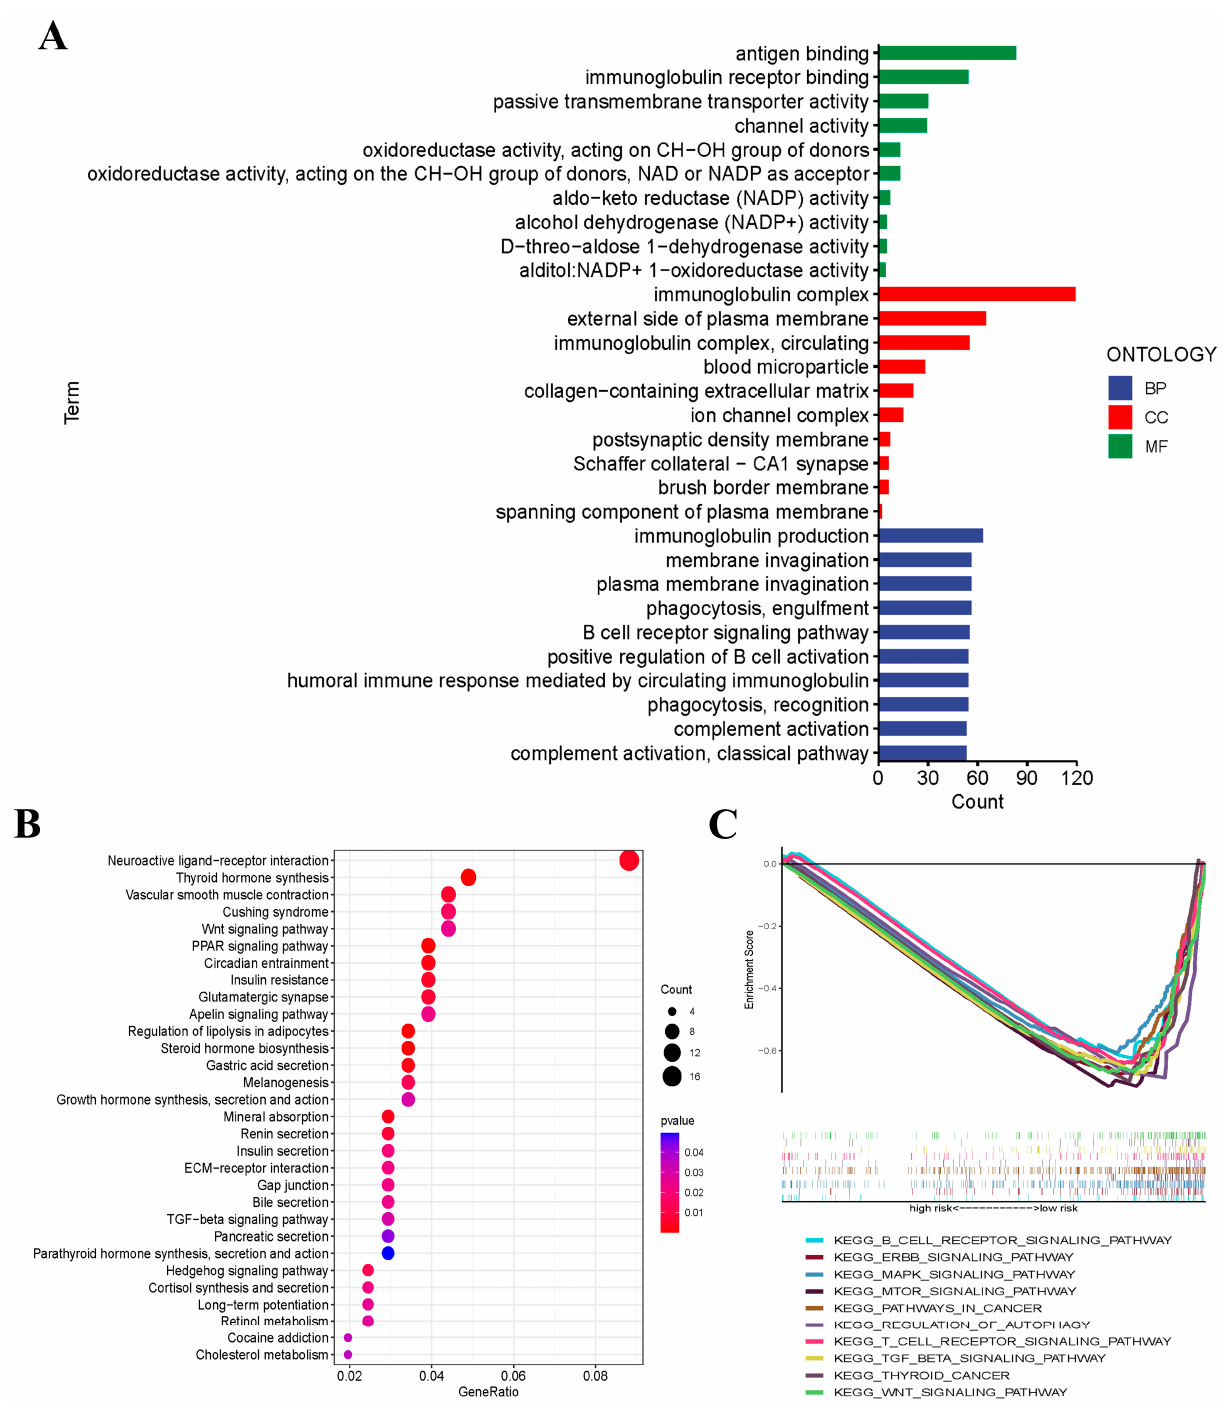
Figure 5. Functional enrichment analysis based on the DEGs. ( A ) Barplot graph for GO enrichment. ( B ) Bubble graph for KEGG pathways. ( C ) Gene set enrichment analysis (GSEA) showed the significantly enriched hallmarks of tumor sets based on the risk signature in TCGA.